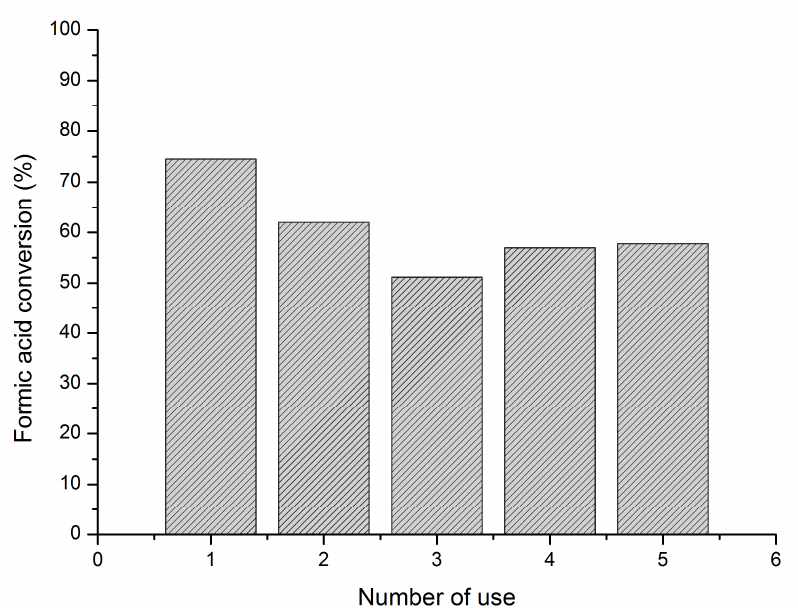
Figure 5. Reusability of Pd/AC-e. Reaction conditions: substrate/metal molar ratio: 2000:1, 50 °C, 0.5 M HCOOH, 750 rpm.